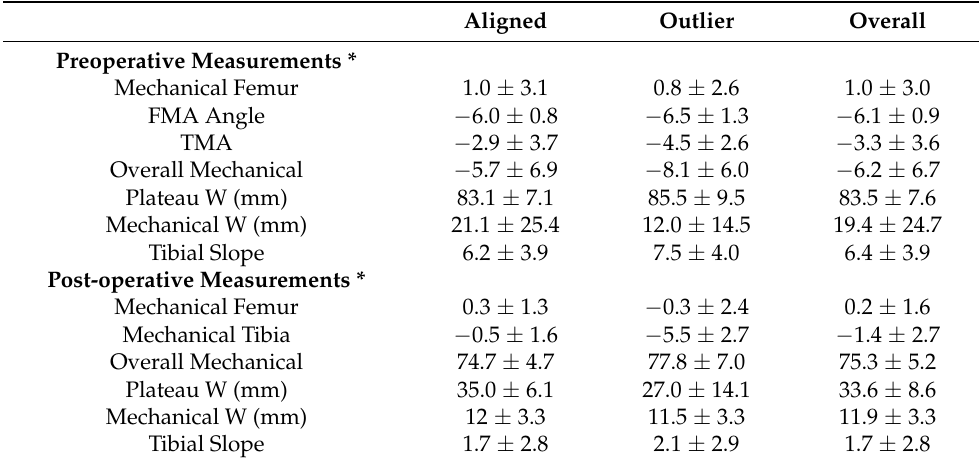
Table 1. Mean ± standard deviation of pre- and post-operative radiographic measurements among aligned and outlier